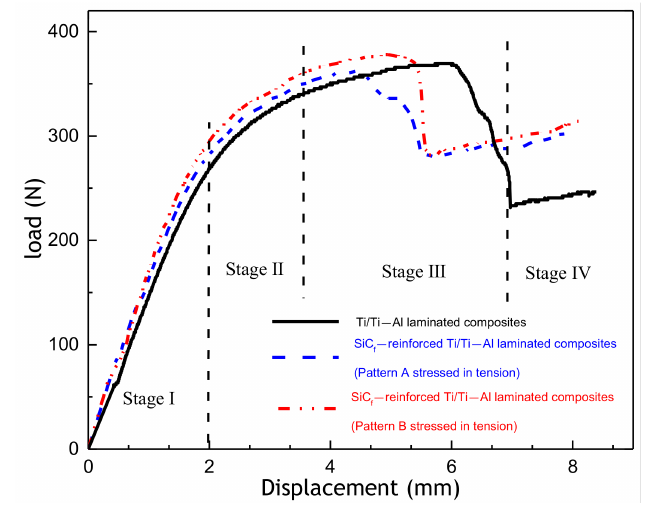
Figure 16. Load–displacement curves of the fabricated laminated composites.